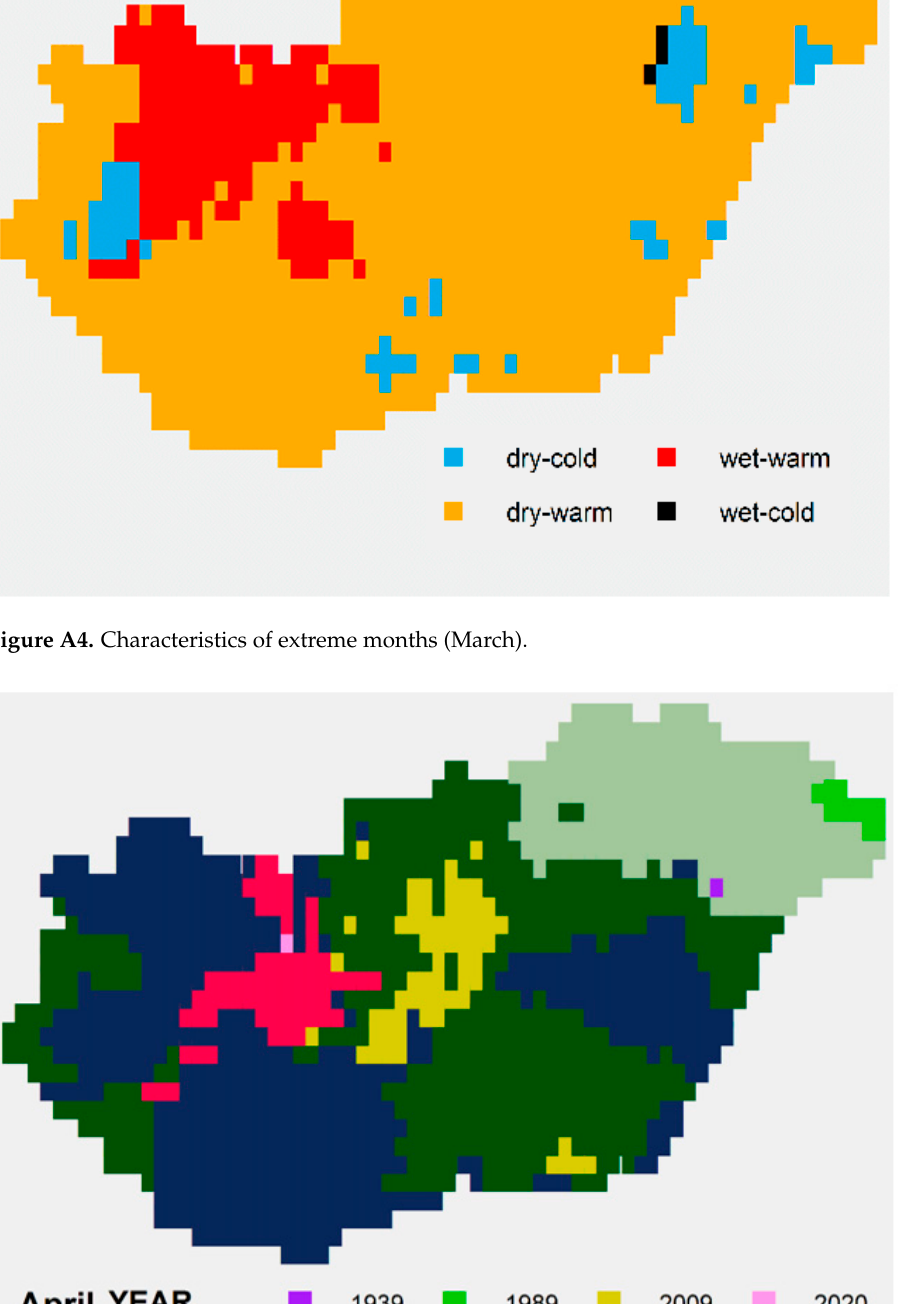
Figure A5. April: Year of maximum SPTI values, 1871–2020.